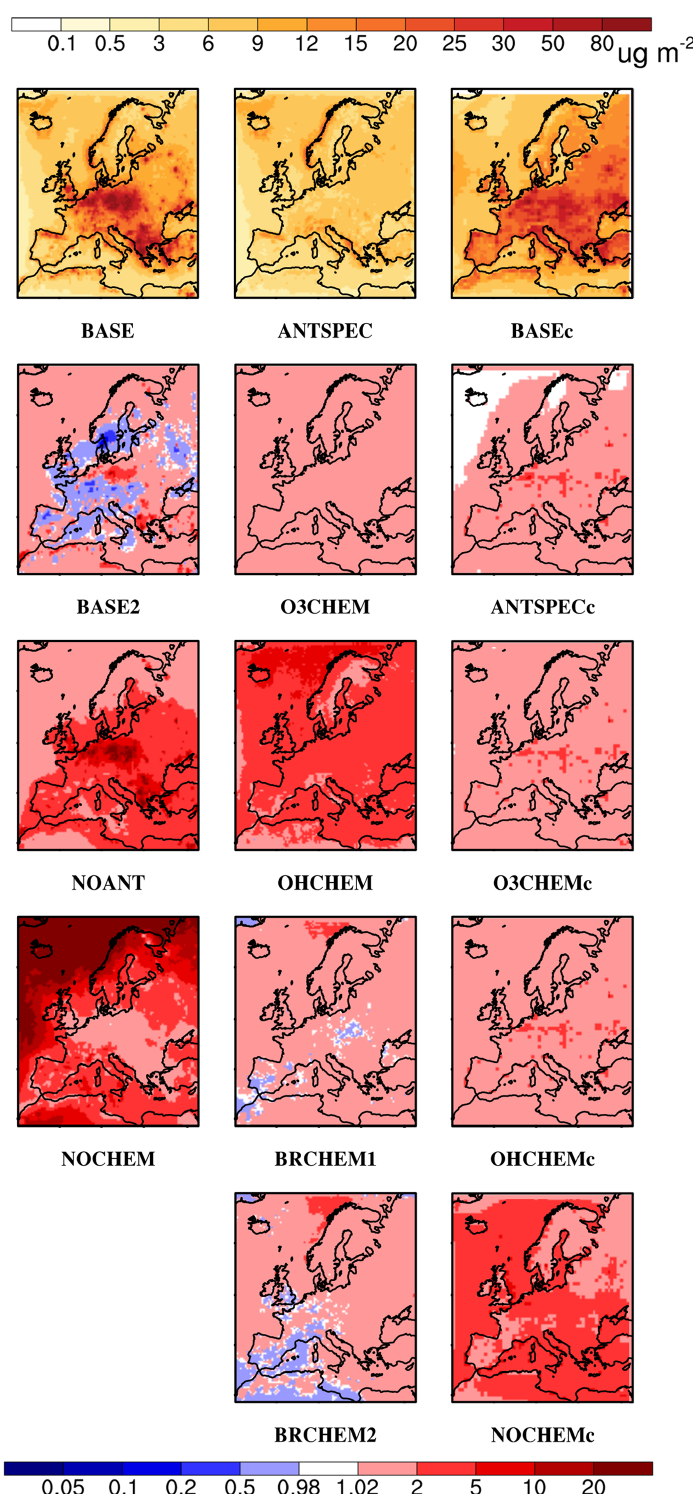
Figure 8. The total Hg deposition and the ratio of deposition in the sensitivity runs compared to BASE, ANTSPEC and BASE C . The Hg total deposition is shown in the first row for BASE, ANTSPEC and BASE C experiments (upper colour label), while the ratio (lower colour label) of these with relative sensitivity runs is reported over the relative column: BASE2, NOANT and NOCHEM ratios (left column) are referred to as BASE experiment, O3CHEM, OHCHEM, BRCHEM1 and BRCHEM2 (central column) ratios are referred to as ANTSPEC experiment, and ANTSPEC C , O3CHEM C , OHCHEM C and NOCHEM C (right row) ratios are referred to BASE C